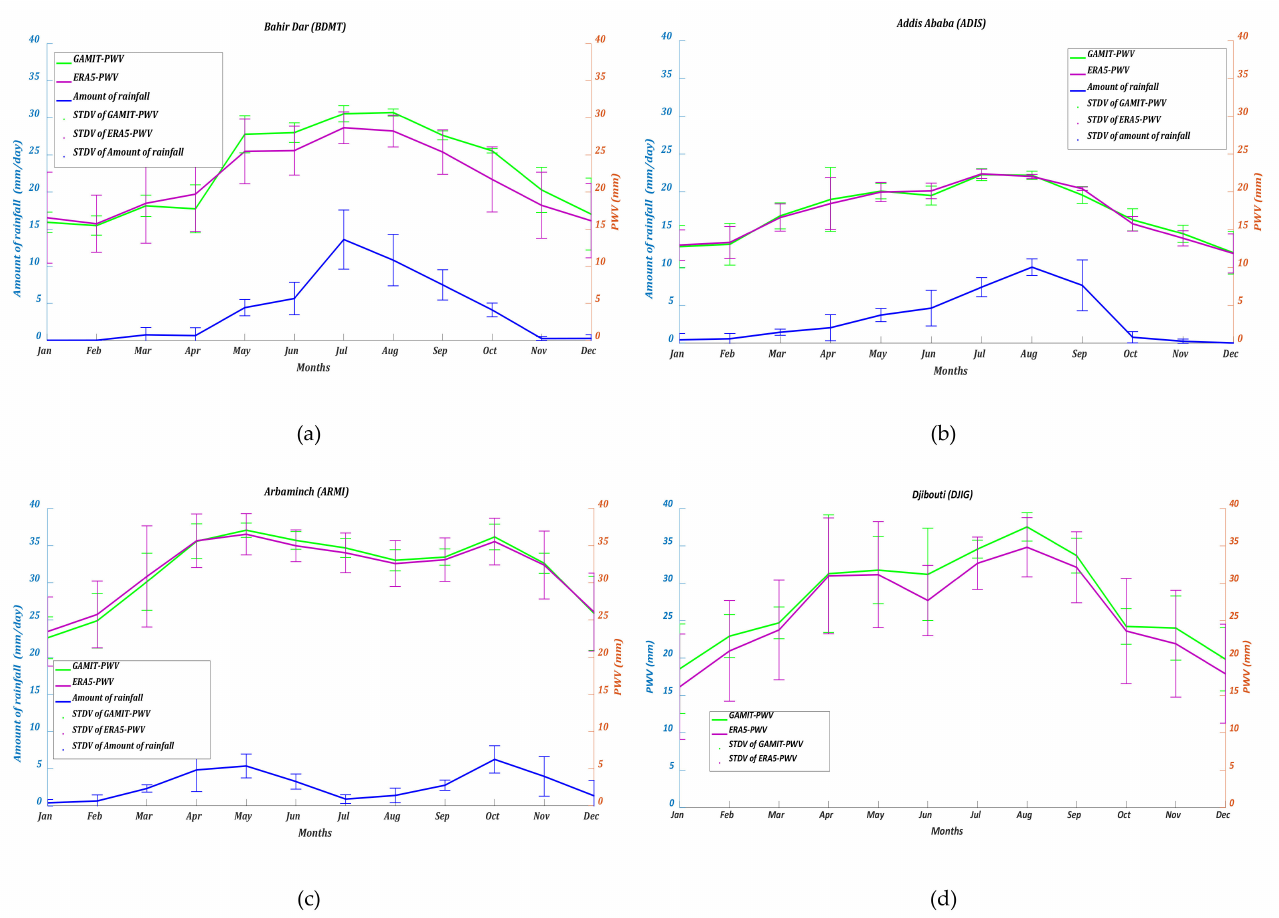
Figure 3. Seasonal variations of GAMIT-PWV (green), ERA5-PWV (purple) and rainfall rate (blue) for the ( a ) BDMT ( b ) ADIS ( c ) ARMI, and ( d ) DJIG stations. The inter-annual variability is represented with the 1 sigma error bars and denoted by STDV (standard